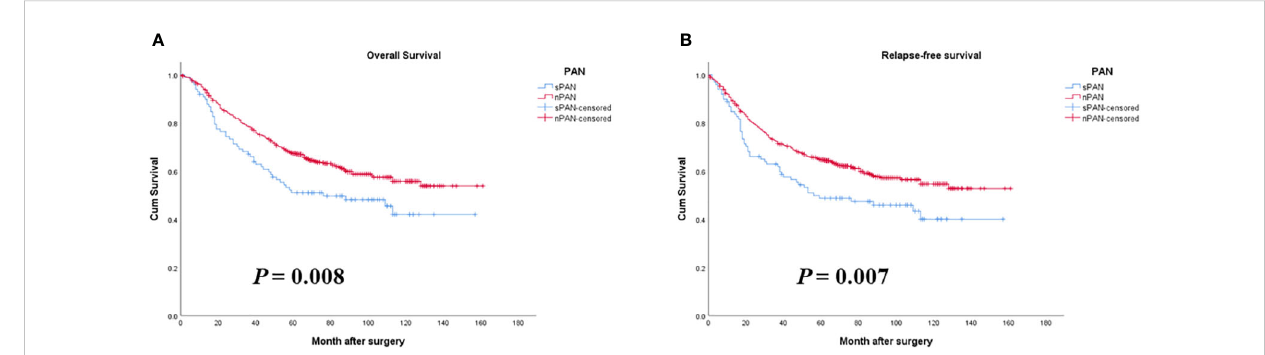
FIGURE 3 Survival curves for GC patients with SPAN and nPAN. (A) Patients with SPAN had worse OS than patients with nPAN ( p = 0.008); (B) Patients with SPAN had worse RFS than those with nPAN ( p = 0.007). PAN, para-aortic lymph node; sPAN, small para-aortic lymph node; nPAN, non para-aortic lymph node; GC, gastric cancer; OS, overall survival; RFS, relapse-free